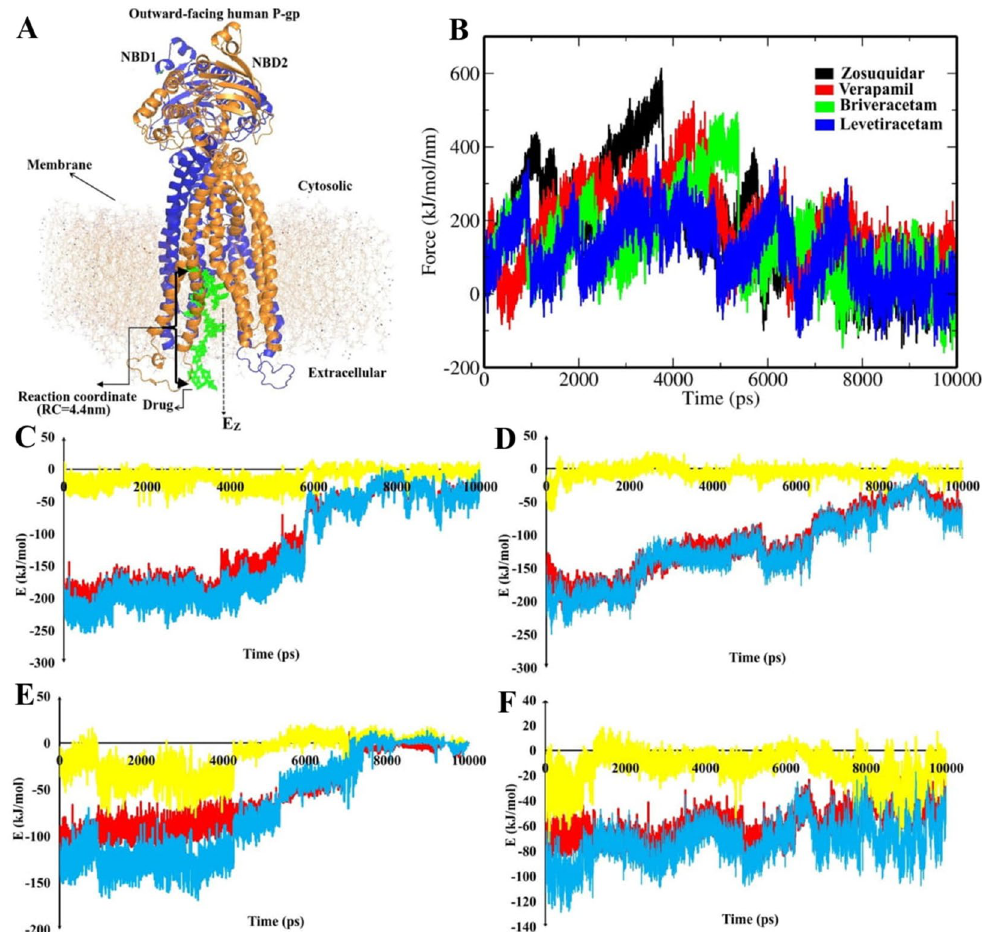
Figure 2. ( A ) Structure of P-gp in the bilayer membrane at the beginning of SMD, and different binding modes of a drug moving along the channel. ( B ) Force changes during the drug transport process through the SMD simulation. ( C – F ) Graphs of the SMD energies between P-gp and respectively zosuiquidar, verapamil, briveracetam and levetiracetam, indicating the short-range Coulombic interactions (yellow), short-range Lennard–Jones interactions (red), and the total interaction energy